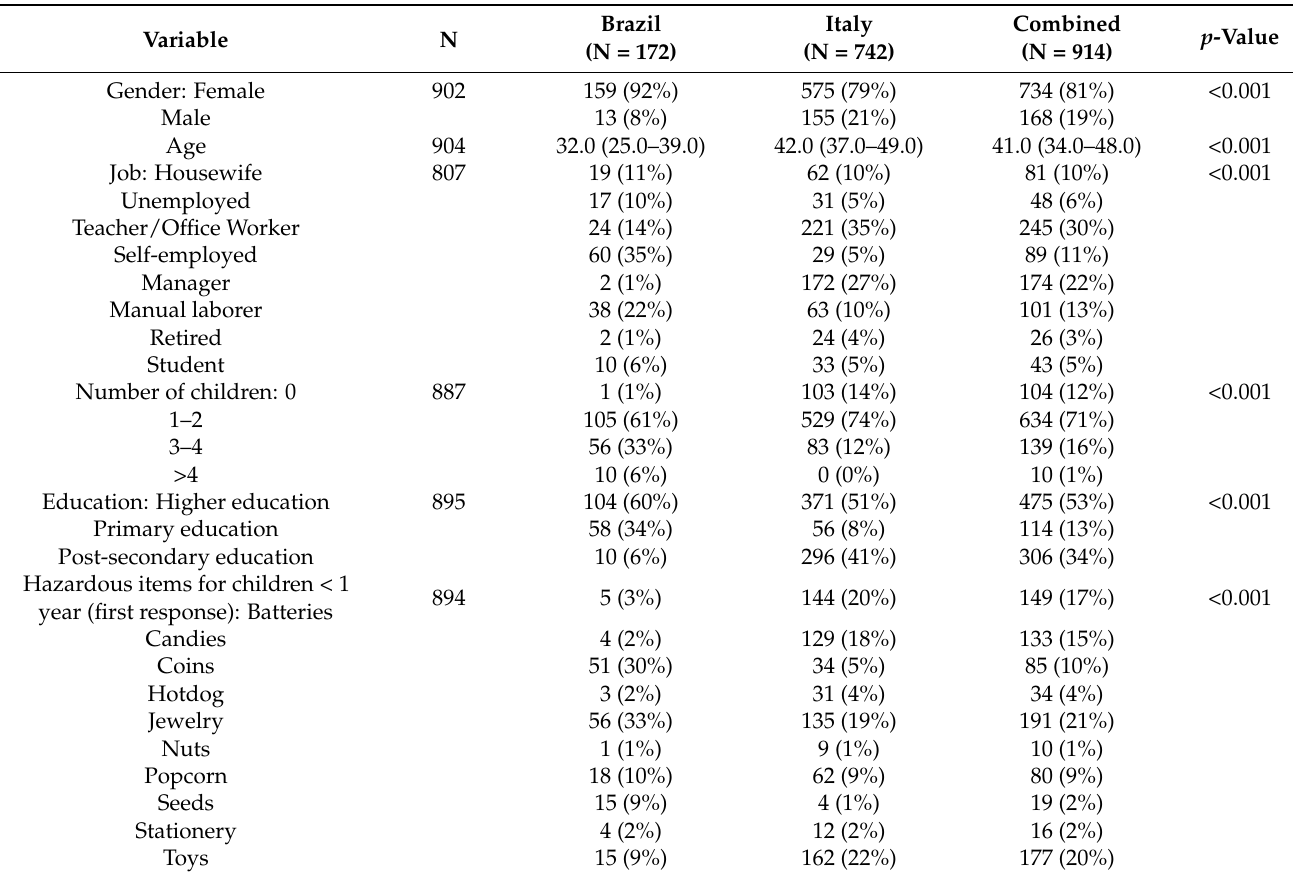
Table 1. Characteristics of Italian and Brazilian respondents. Continuous data are reported as median (I, III quartiles); categorical data are reported as percentages and absolute frequencies. Wilcoxon rank sum tests were performed for continuous variables and the Pearson’s Chi-square test, or Fisher’s exact test, whatever appropriate, for categorical